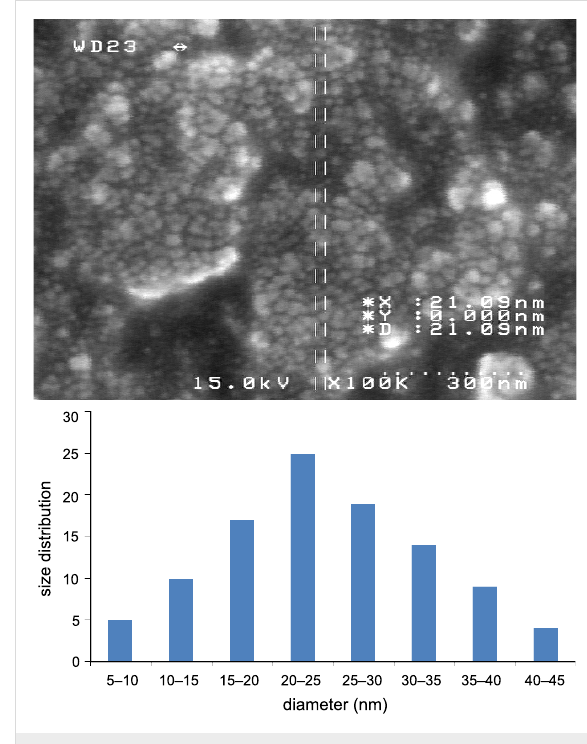
Figure 4: SEM micrograph of compound 2 and histogram indicating the size distribution in the SEM images.